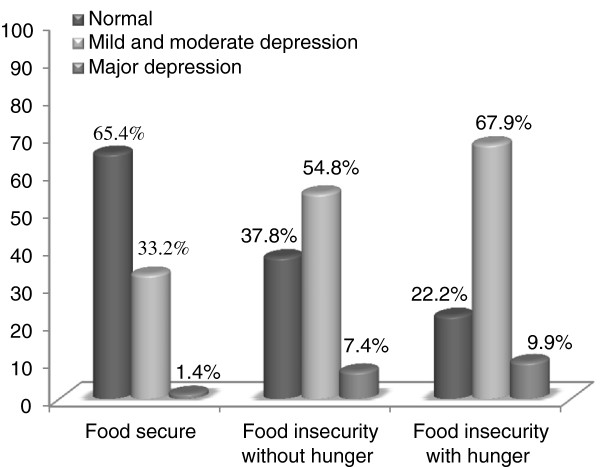
Distribution of samples according to food security and depression status.